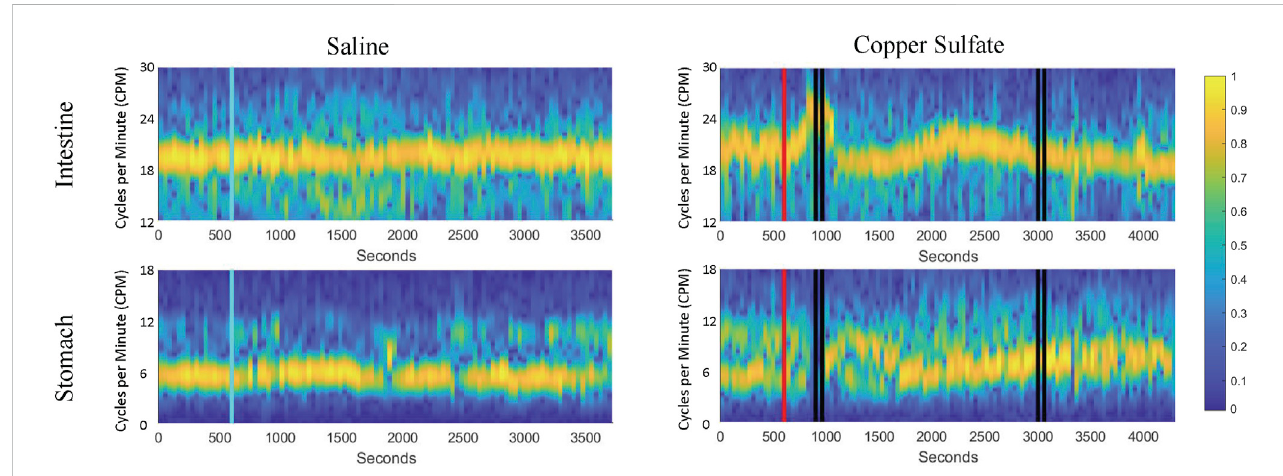
FIGURE 5 Spectrogramsofduodenal and stomachslow-waveactivityfollowing administration ofsaline(leftcolumn)and CuSO 4 (right column).Yellowrepresents the dominant frequency and blue the least dominant (scale of normalized signal power, 0 – 1). As in Figure 4, the blue vertical line indicates saline administration, the red vertical line designates CuSO4 administration, and the black vertical lines show when retching